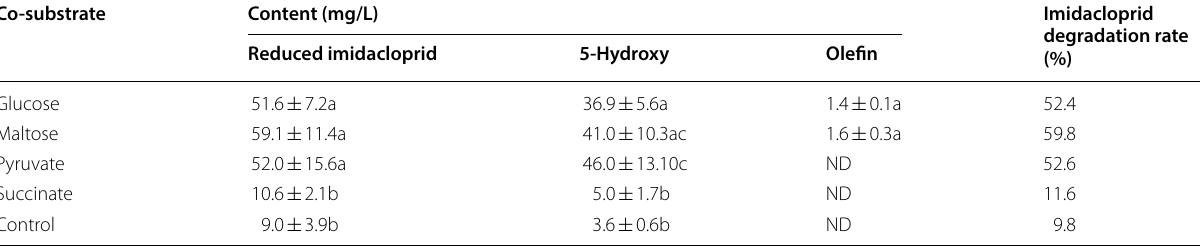
The OD 600 of the resting cell transformation broth was 5. The transformation time was 96 h. The data represent the mean values of triplicates. Mean values ( within a column followed by different letters are significantly different at p